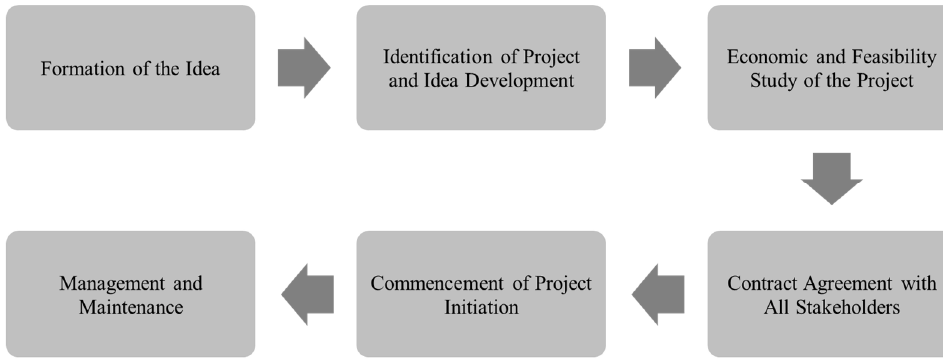
Figure 3. Stages of Real Estate Development.